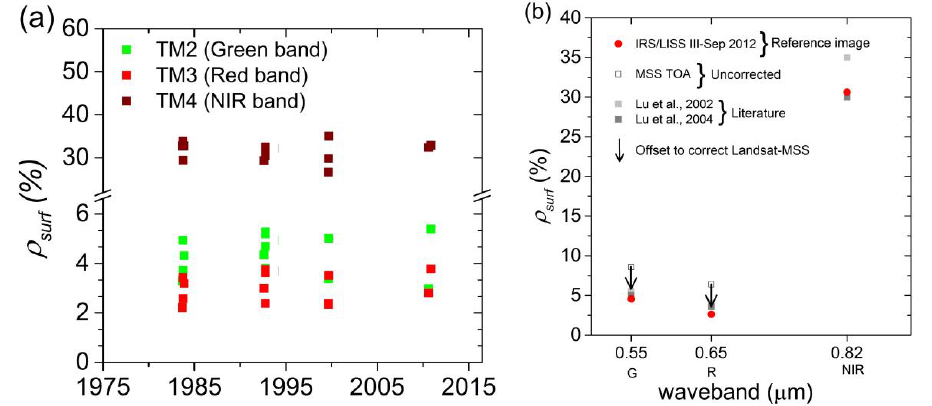
Figure 3. ( a ) DDV (Dark Dense Vegetation) spectra for dry seasons (August–October) extracted